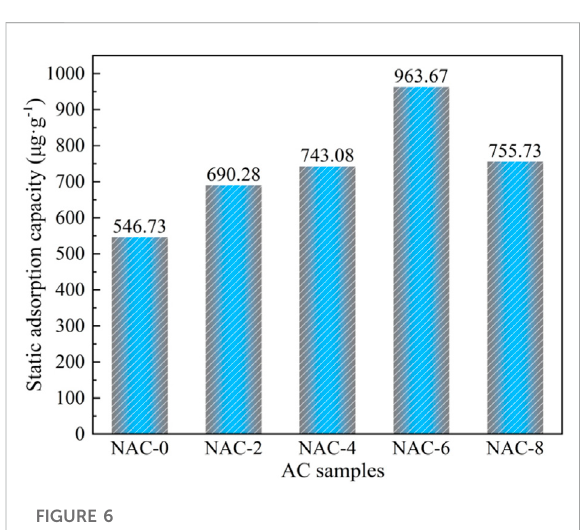
FIGURE 6 Formaldehyde static adsorption capacity of AC samples before and after modi fi cation.